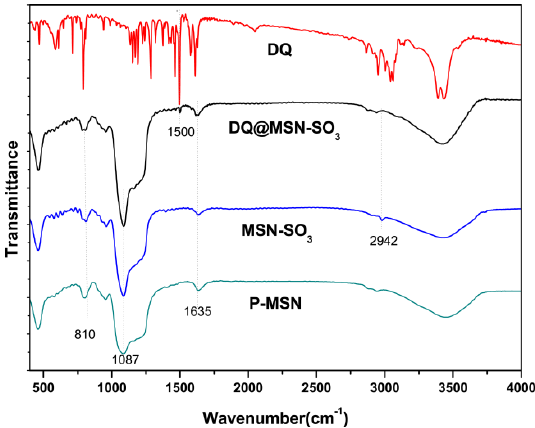
Figure 4. Fourier transform infrared (FT-IR) spectra of P-MSN, MSN-SO 3 , DQ, and DQ@MSN-SO 3 .